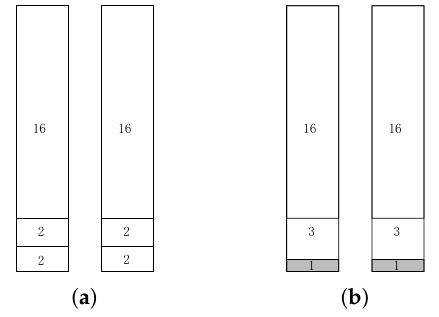
Figure 4. An example, ( a ) optimal solution; ( b ) larger packet